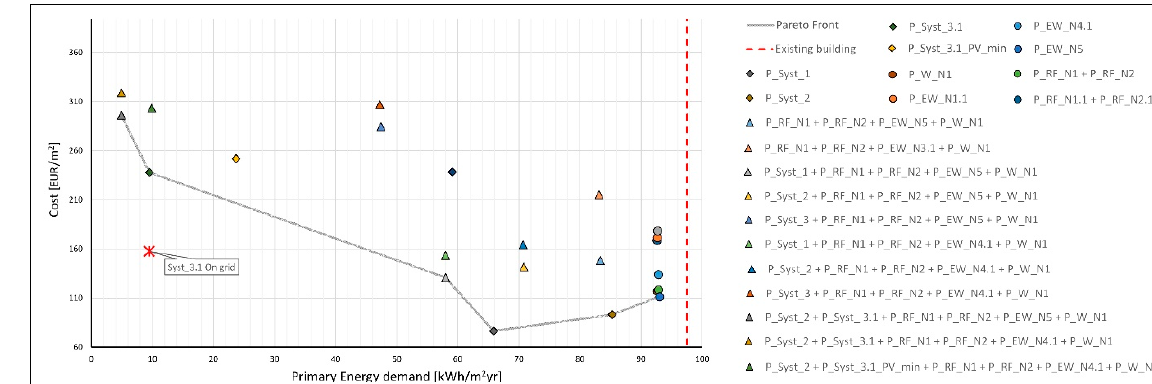
Figure 14. Cost-optimality method results for the financial scenario for both single redevelopment measures and their combinations and discount factor equal to 4% for Poliziano school. The red line in the graph shows the primary energy consumption for the existing building.